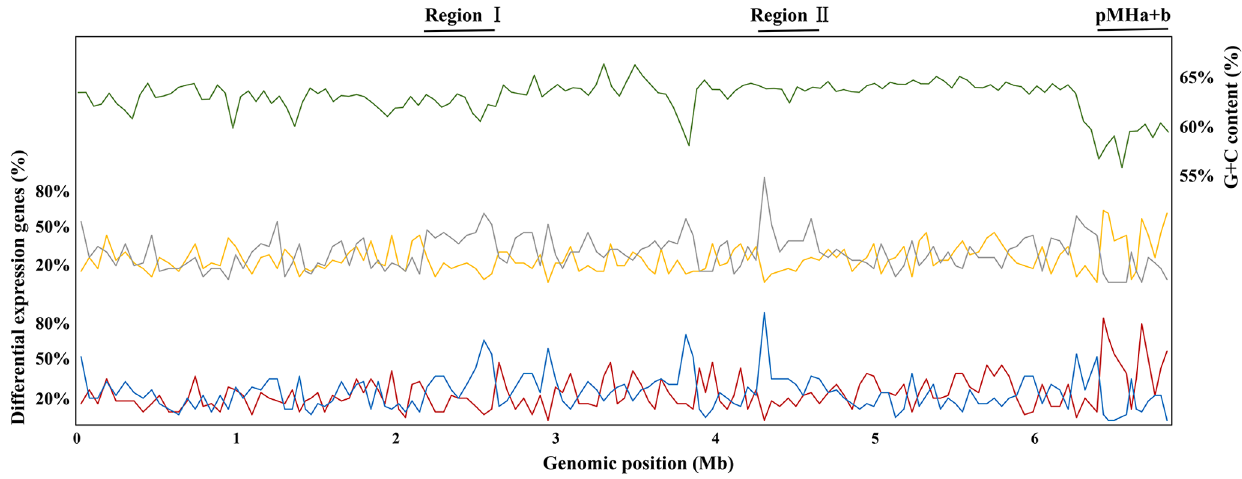
Figure 2. Visualization of global transcriptional profiles as determined by RNA-Seq and Microarrays. The plot shows a summary of RNA-Seq and Microarrays expression data at all regions in bacteroids. Across the entire genome, the percentages of up-regulated genes of RNA-Seq and Microarrays are shown in yellow and red, while those of the down-regulated shown in gray and blue, respectively. The G + C content is in green. The percentage of differentially expressed genes and the GC content were computed with a sliding window of every 50 genes. Note the most prominent up-regulation in the symbiosis plasmids and the most prominent down-regulation in regions I and II in the chromosome.